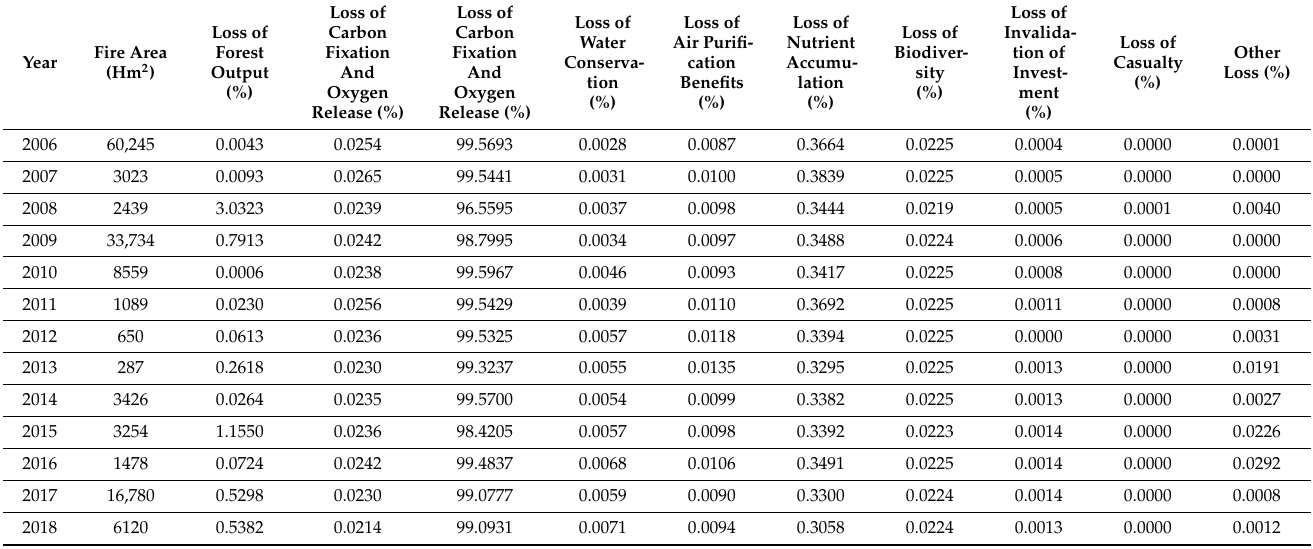
Table 6. Proportion of forest fire loss types in Inner Mongolia over the